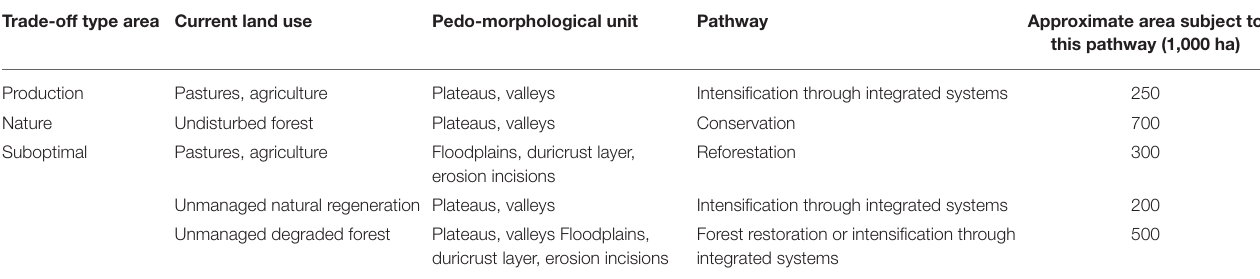
TABLE 3 | Pathways to optimize ecosystem services in Paragominas in terms of current land use and pedo-morphological